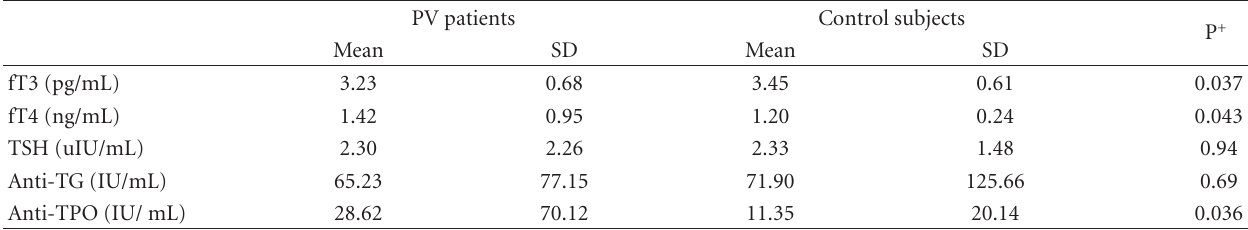
Table 1: Levels of anti-thyroid antibodies and thyroid function tests in patients with PV and control subjects. PV